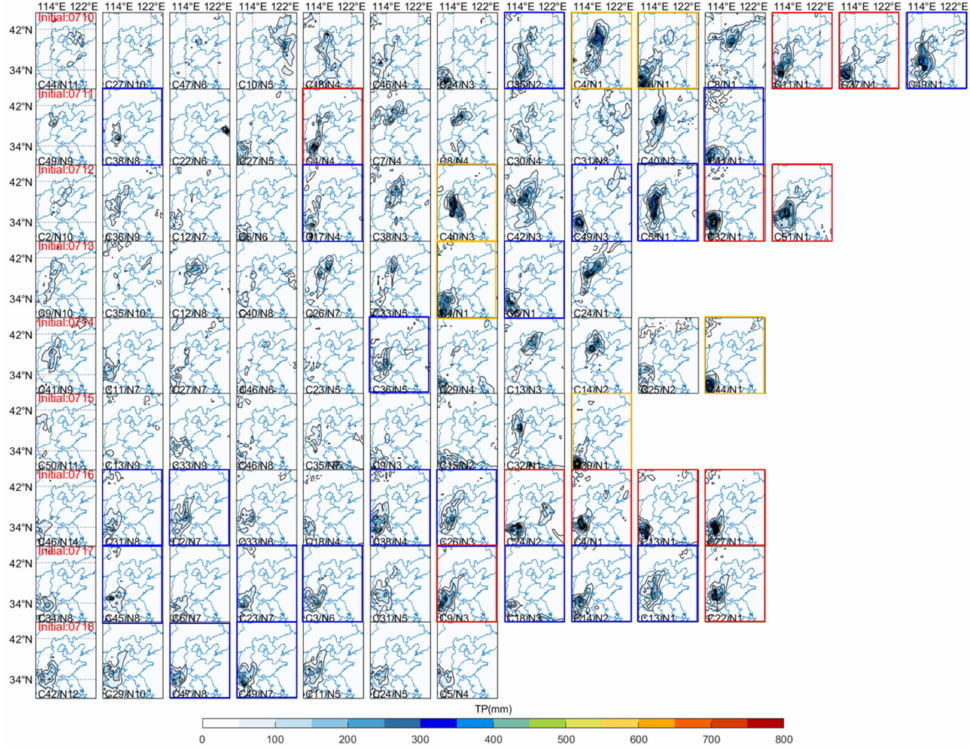
Figure 6. EOF_AP clustering results of the accumulated rainfall from 19 to 21 June of the ECMWF ensemble forecasts, with a rolling start time from 12:00 on 10 to 18 July. The red box indicates that the maximum accumulated rainfall exceeds 400 mm in Henan, and is forecasted by this member. The yellow box indicates that the maximum accumulated rainfall exceeds 400 mm in the forecast area without Henan. The blue box indicates that the maximum accumulated rainfall is between 200 mm and 400 mm in Henan. If there are members which satisfy various conditions, they will be marked with the priority of red, yellow, and